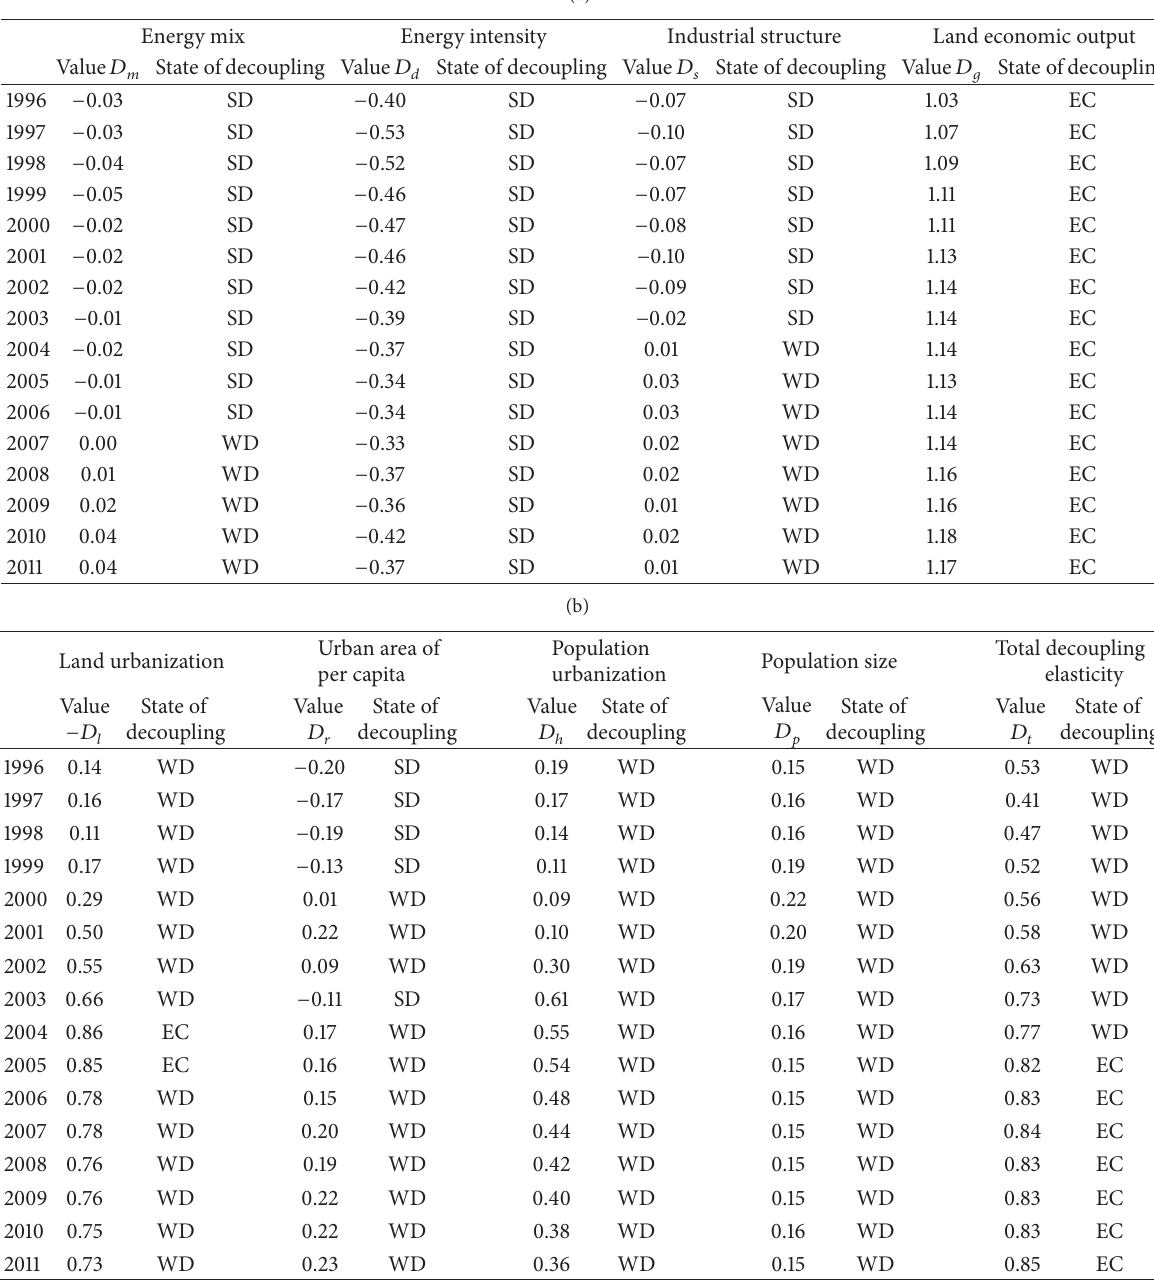
Table 3: Decoupling elasticity values and decoupling states of various decomposition factors in Guangdong from 1996 to